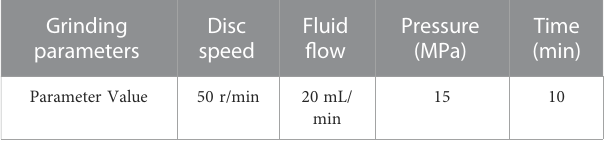
TABLE 1 Grinding experiment